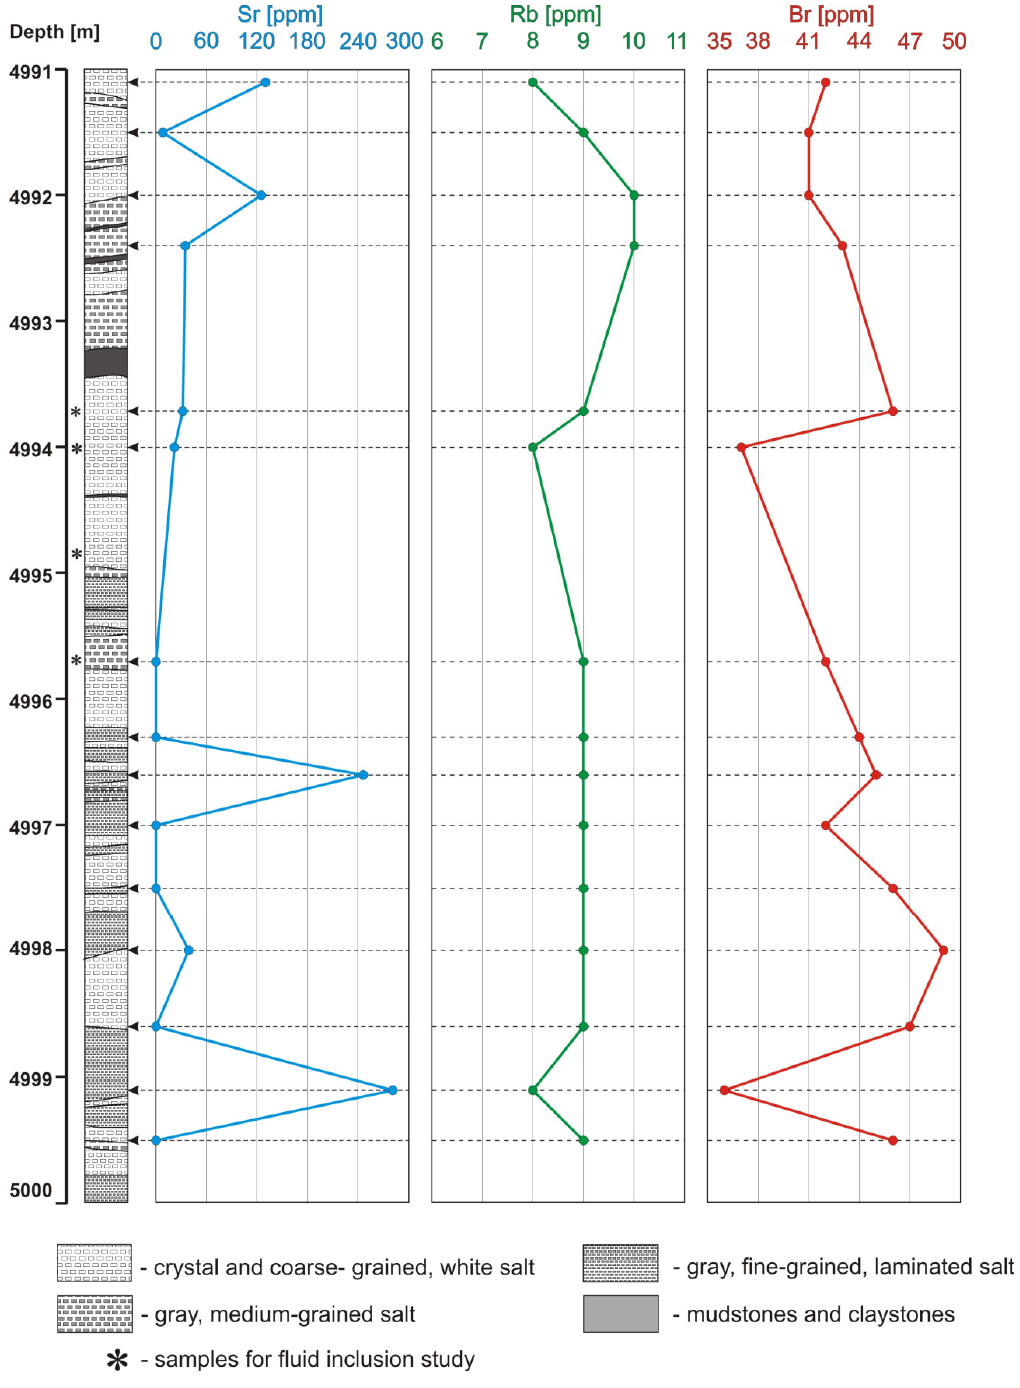
Figure 5. Distribution of strontium, rubidium, and bromine, with the lithological successions of salt deposits of the Huwniki-1